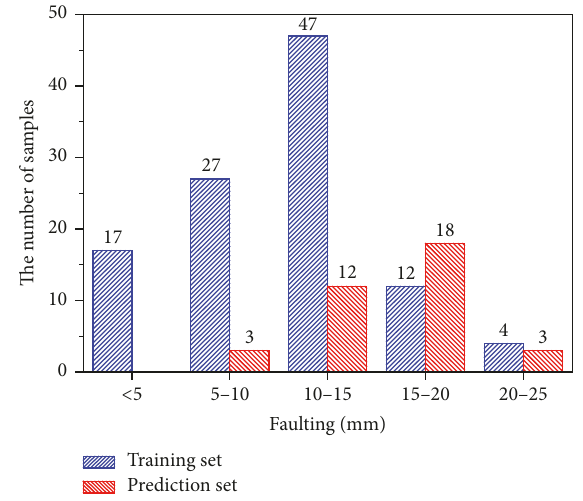
Figure 1: Faulting distribution of training set and prediction